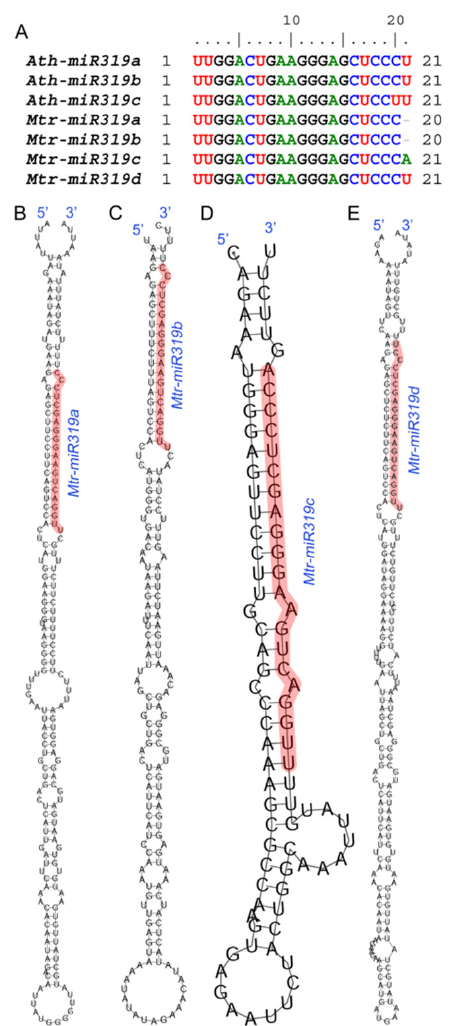
Figure 1. Sequence analysis of miR319 and precursor secondary structure prediction: multiple se- quence alignment of miR319 in A. thaliana and M. truncatula ( A ), A. thaliana sequences of Ath-miR319a , Ath-miR319b and Ath-miR319c , and M. truncatula sequences of Mtr-miR319a , Mtr-miR319b , Mtr-miR319c and Mtr-miR319d were aligned; secondary structure prediction of the precursors of Mtr-miR319a ( B ), Mtr-miR319b ( C ), Mtr-miR319c ( D ), and Mtr-miR319d ( E ). The mature sequences of Mtr-miR319s are marked in red.